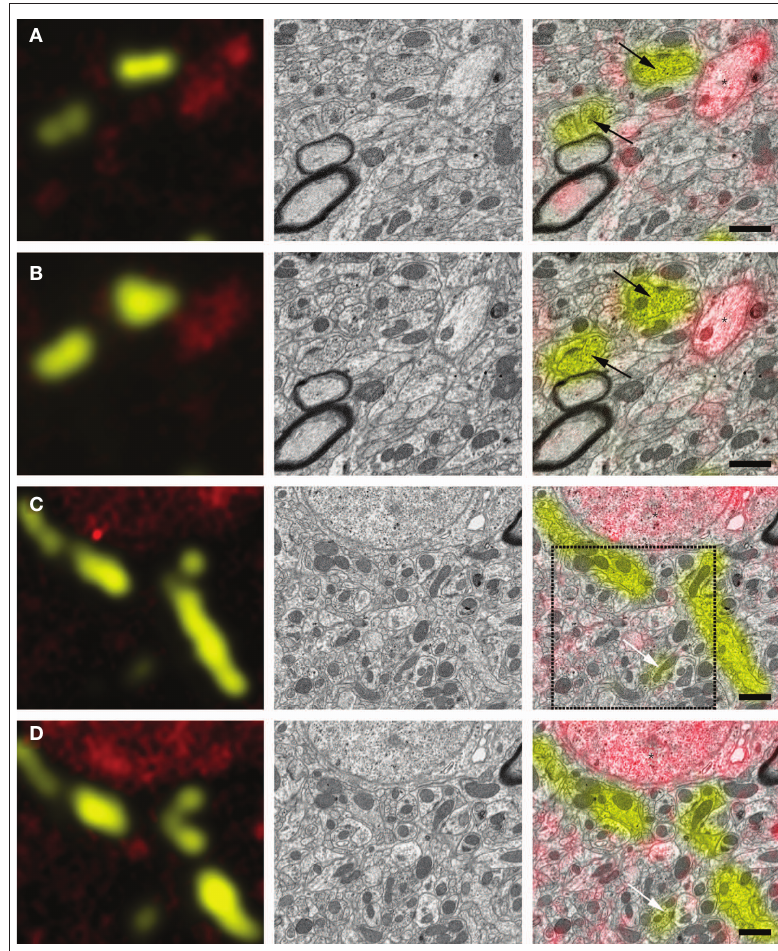
Figure 3 | Correlation of eM and LM micrographs of serial ultrathin sections. Left column: superposition of light micrographs of two fluorescence channels associated with two different projection neuron populations (red: Texas Red-dextran direct fluorescence of RA-projecting HVC neruons; yellow: anti-Lucifer Yellow immunolabeling of HVC-projecting Uva neurons). Middle column: SEM micrographs of the same region as in the left column. Right column: immunofluorescence image is superimposed on the SEM micrograph, allowing for classification of synaptic terminals [black arrows in (A,B) ], small neural processes [white arrows in (C,D) , asterisk in (A,B) ], and cell somata [asterisks in (C,D) ]. (A,B) , as well as (C,D) are images taken from adjacent section pairs: immunofluorescence signal on neighboring sections coincides with the same structures as identified in the EM. The region enclosed by the dashed square is represented in higher magnification in Figure 4 . Scale bar 1